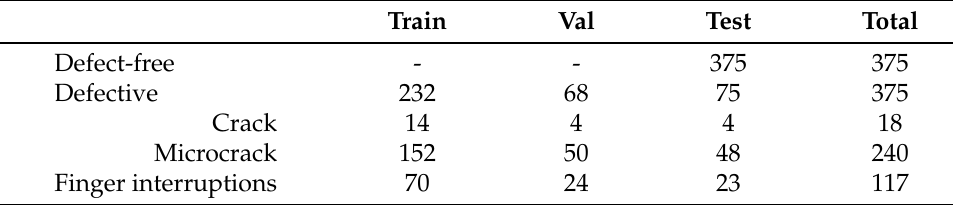
Table 5. Dataset sample distribution for the supervised part experiment.